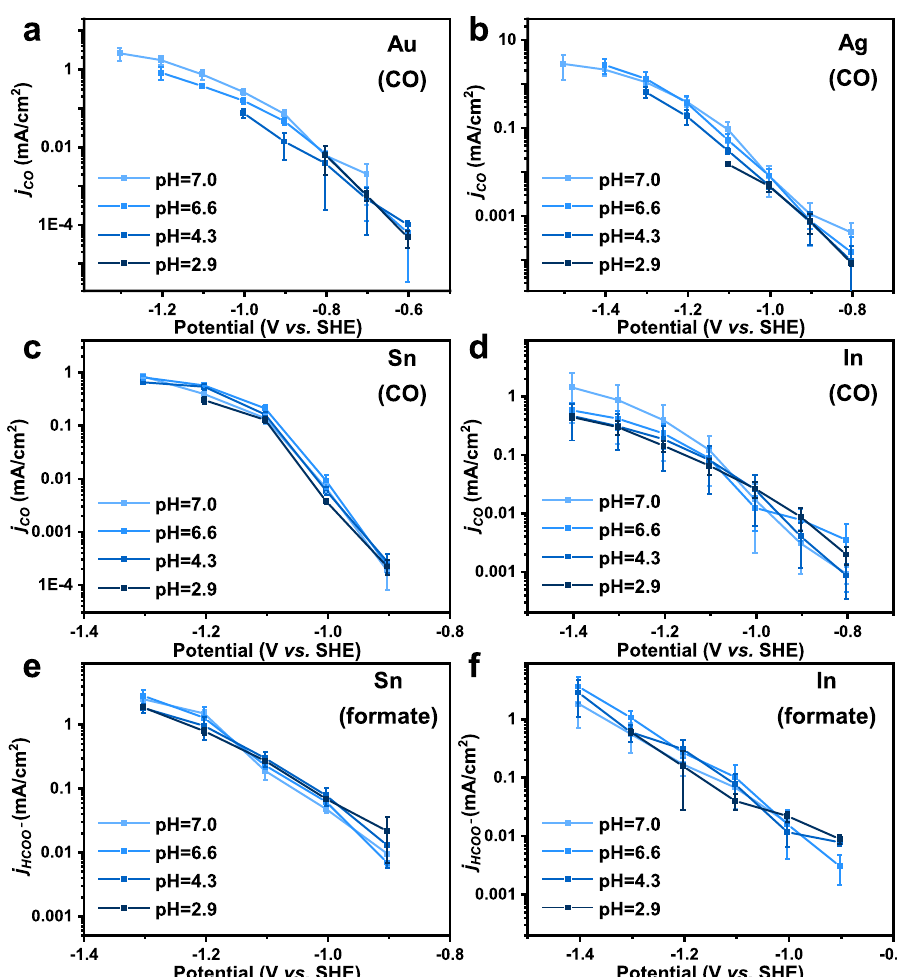
Fig. 1 The pH dependency for CO 2 ER toward CO and formate. The j CO for Au ( a ), Ag ( b ), Sn ( c ), and In ( d ) catalysts in electrolytes with different pH. The j − for Sn ( e ) and In ( f ) catalysts in electrolytes with different pH. Error bars are means ± standard deviation ( n = 3 HCOO